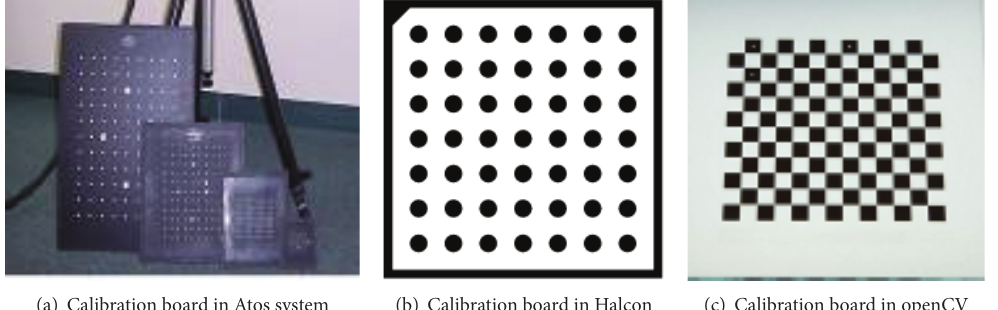
Figure 1: Calibration of 2D board patterns commonly used.